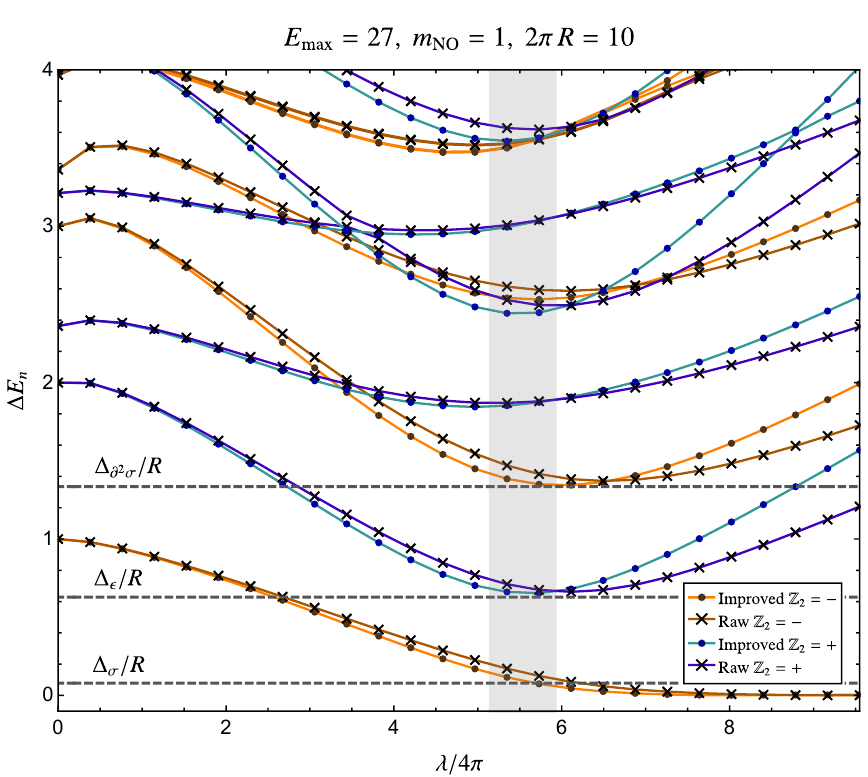
Fig. 6. The excitation energy spectra as a function of the φ 4 coupling λ/ 4 π . The states belonging to the (cid:90) -even (-odd) basis are shown in blue (orange). The raw 2 truncated theory is plotted in dark blue (dark orange) using cross markers, while the improved theory is plotted light blue (orange) using dot markers. For clarity, lines are drawn to connect the data points within each excited state. The dashed horizontal lines correspond to the known theoretical values for the operator dimensions of the 2D Ising model, and the grey band covers the predicted range of the critical